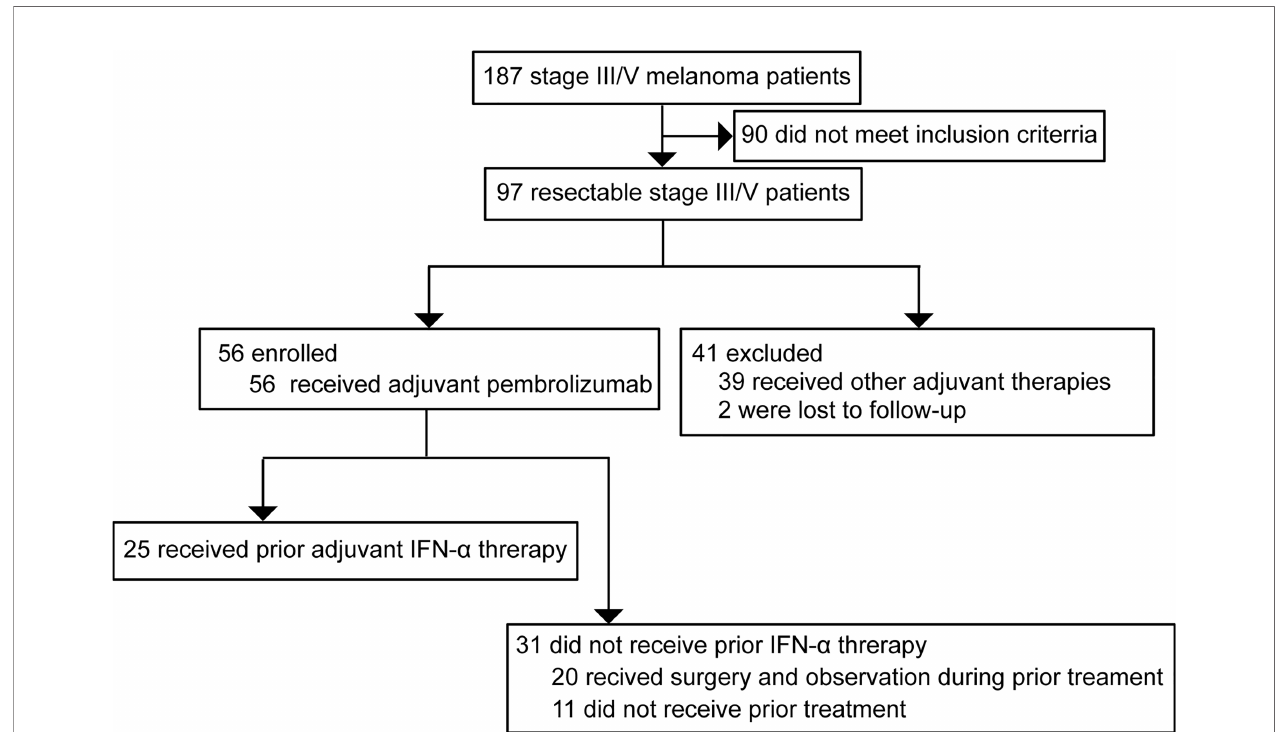
FIGURE 1 | Study design, screening, and enrollment of the